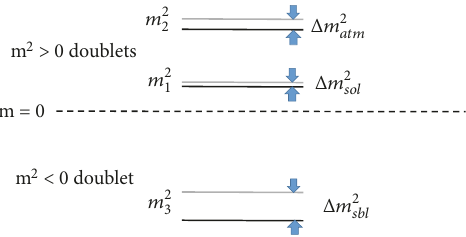
Figure 3: The three active-sterile doublets and their splittings in the 3+3 model (not drawn to scale). Note that two doublets have 𝑚 2 > 0 and one has 𝑚 2 < 0. The values for the three masses found from a nonstandard analysis of SN 1987A data are given in the text.